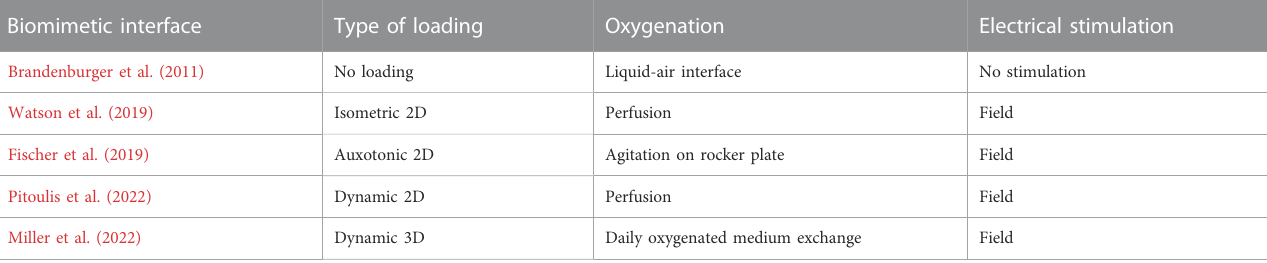
TABLE 1 Overview of different biomimetic cultivation chamber interfaces for myocardial